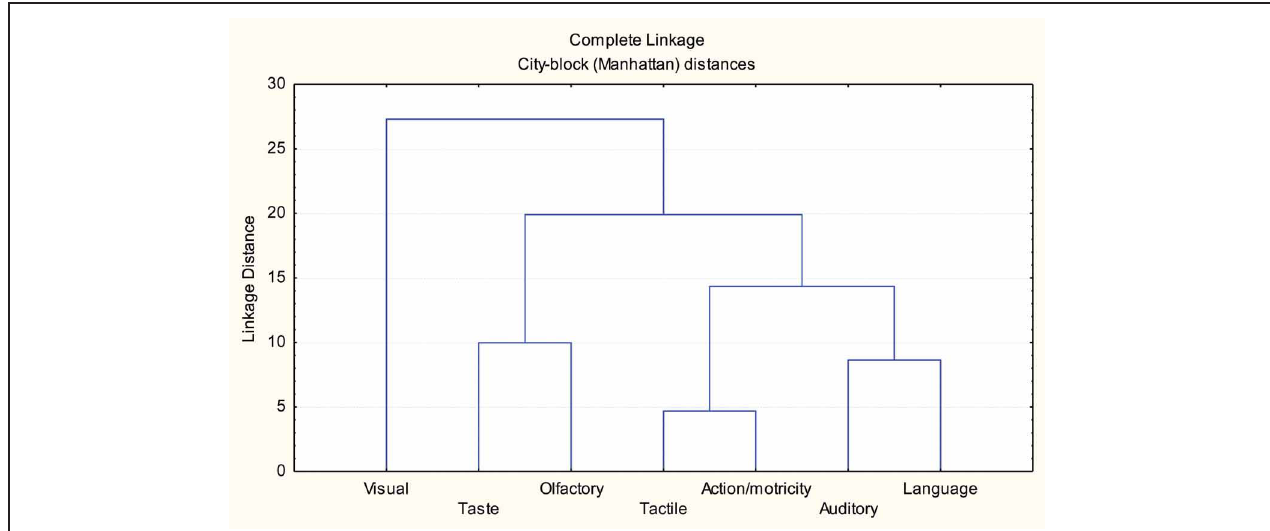
FIGURE 2 | Cluster analysis carried out to explore how the sources of knowledge group together in terms of their specific weight in characterizing the items of all the categories considered in the